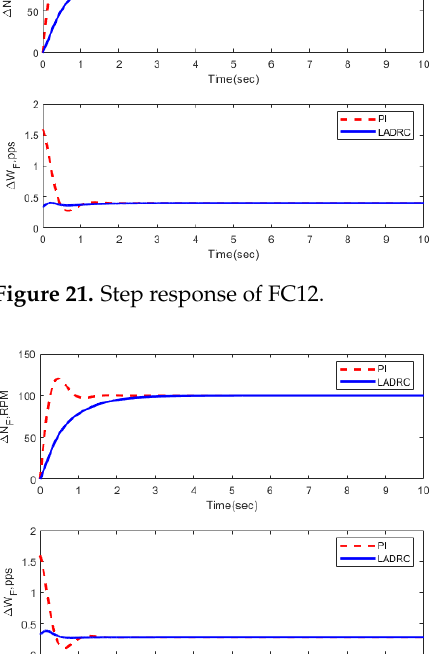
Figure 22. Step response of FC13.